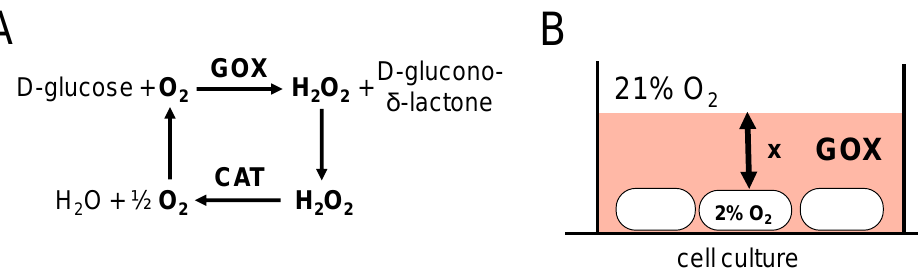
Figure 4. The principle of the glucose oxidase/catalase (GOX/CAT) system for independent control of hypoxia and H 2 O 2 levels (adapted from [87]). ( A ) Stoichiometry of the GOX/CAT system. GOX converts 1 mol oxygen and glucose to 1 mol gluconolactone and H 2 O 2 , while CAT catalyzes the dismutation of 1 mol H 2 O 2 into 0.5 mol oxygen and water. This results in net consumption of oxygen (hypoxia) and efficient control of H 2 O 2 . ( B ) The diffusion distance (x) from the medium surface to the bottom of the culture dish determines the degree of hypoxia besides the activity of oxygen-consuming GOX.